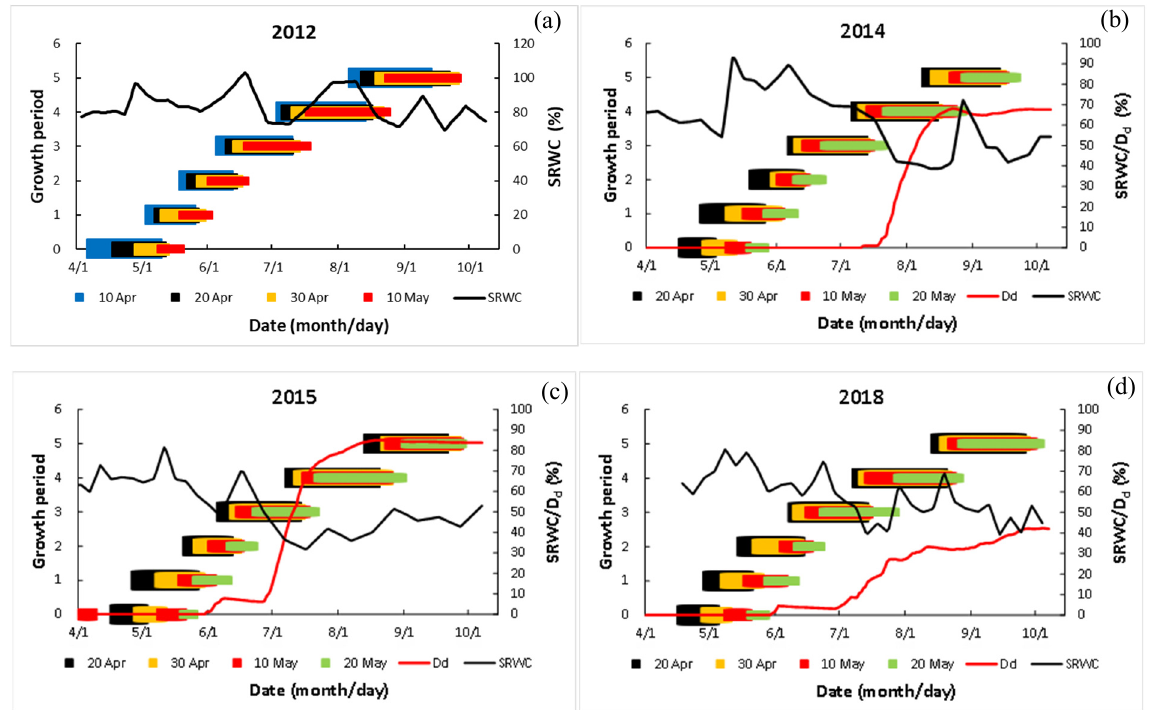
Figure 3. The start and end dates of each of the five growth stages of maize, soil relative water content, and degree of drought in maize sown on different dates: ( a ) 2012, ( b ) 2014, ( c ) 2015, ( d ) 2018. The main axis (the Y axis) marks the growth stages, starting from 0 (sowing to emergence); the numbers 1 to 5 correspond to the growth stages P1 to P5. The number 6 is shown to ensure full display of figure content and has no meaning.